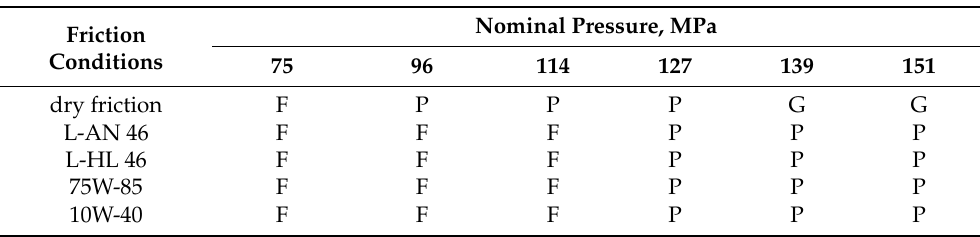
Table 2. The effect of friction conditions on the dominant tribological mechanism (flattening—F, galling—G,